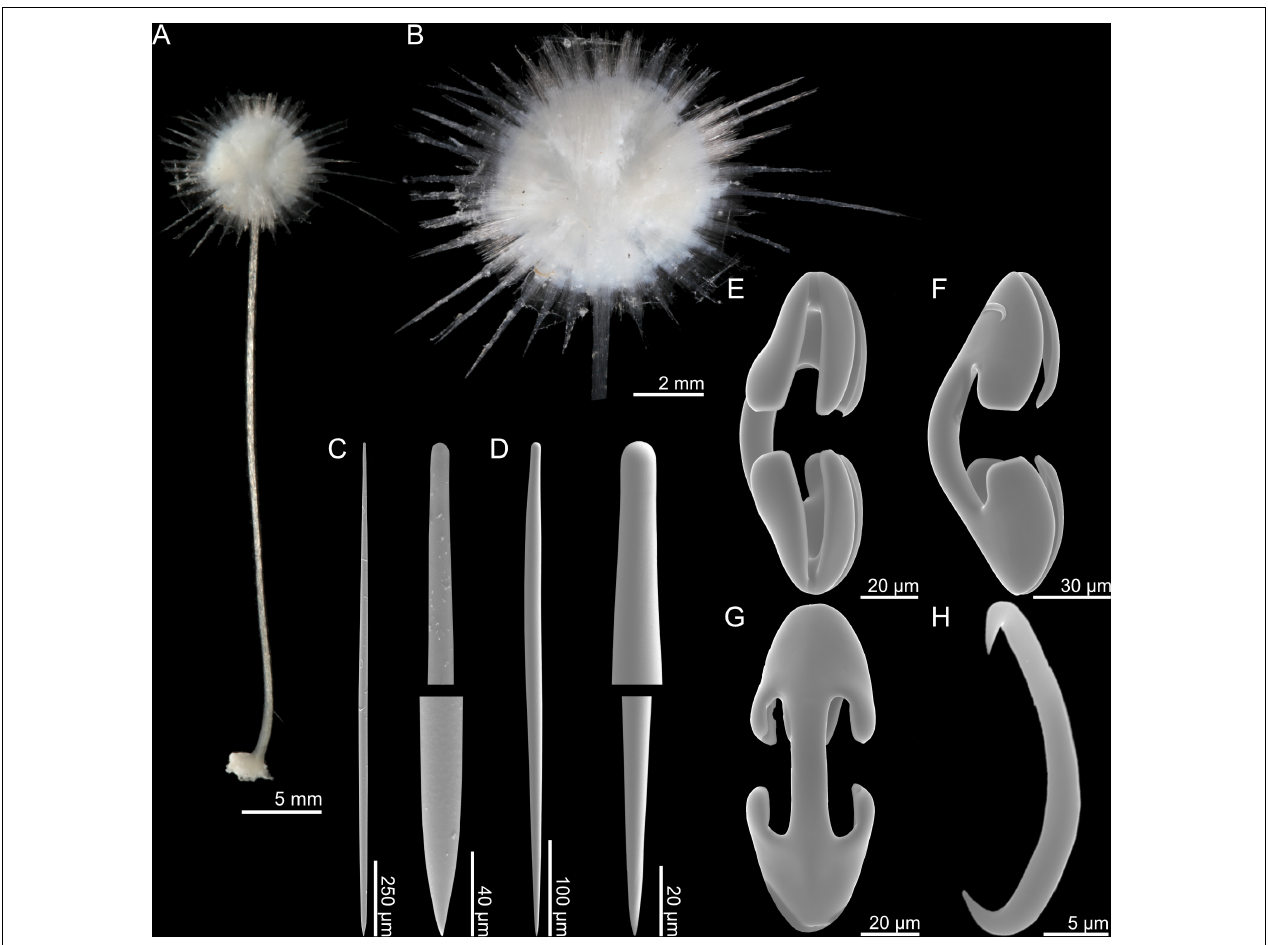
FIGURE 3 | Abyssocladia kellyae n. sp. (A) whole specimen, (B) detail, (C) mycalostyle, (D) subtylostyle, (E–G) arcuate anisochela front, side and back view, and (H)